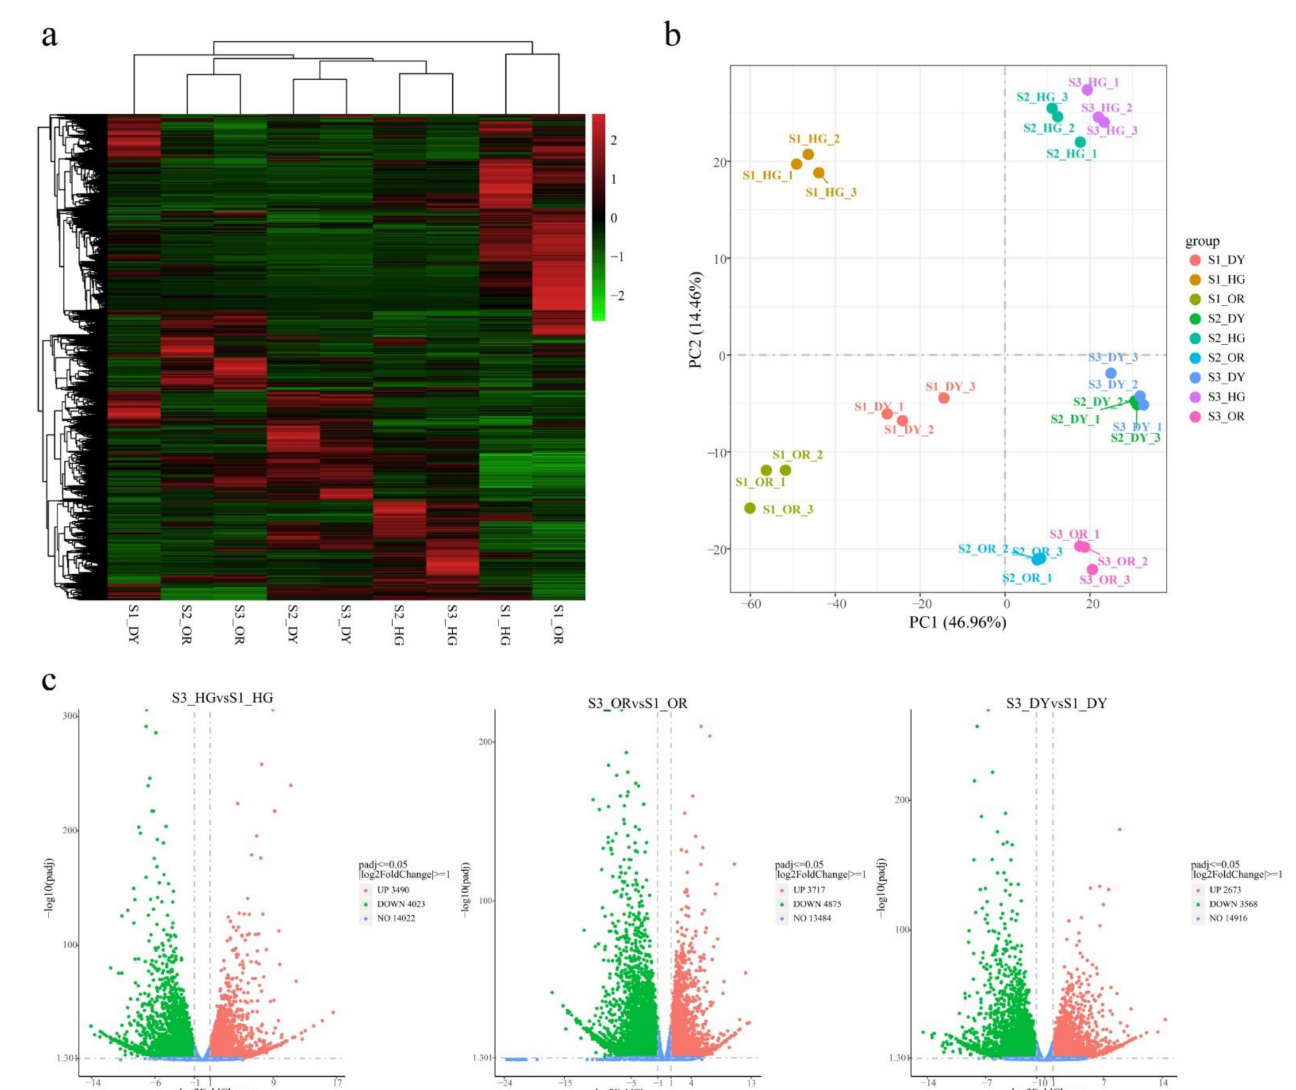
Figure 5. ( a ) Cluster heat map of differentially expressed genes (DEGs) between different samples. Each column in the graph represents a sample, and each row represents a gene. The color in the graph indicates the amount of gene expression in the sample (log10(FPKM+1)). Red color indicates that the gene is highly expressed in the sample, and green color indicates that the gene is lowly expressed. ( b ) PCA scatter plots of different samples based on transcriptome data. ( c ) Volcano plots of DEGs across different groups. The red dots, inns, and blue dots represent up-regulated, down-regulated, and non-significant DEGs, respectively. The horizontal axis represents fold change in gene expression levels, and the vertical axis represents the significance of